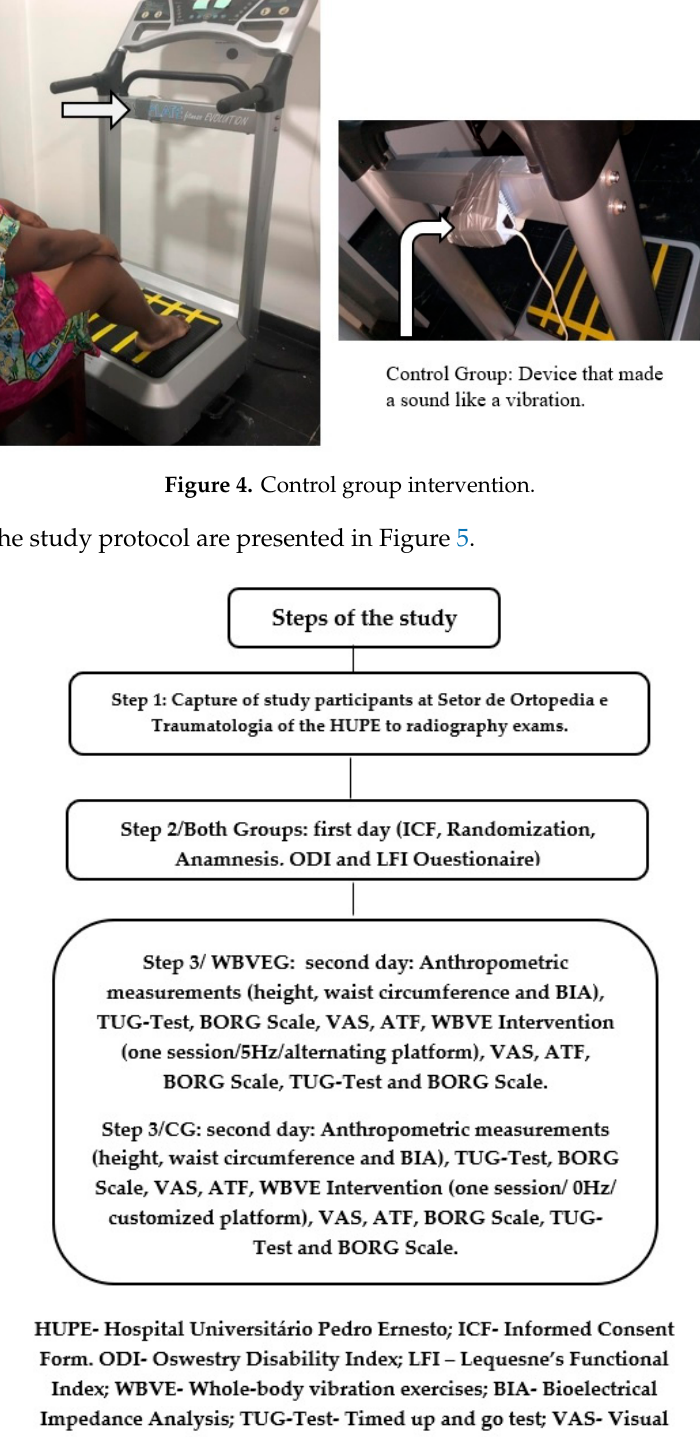
Figure 5. Steps performed in the study protocol.